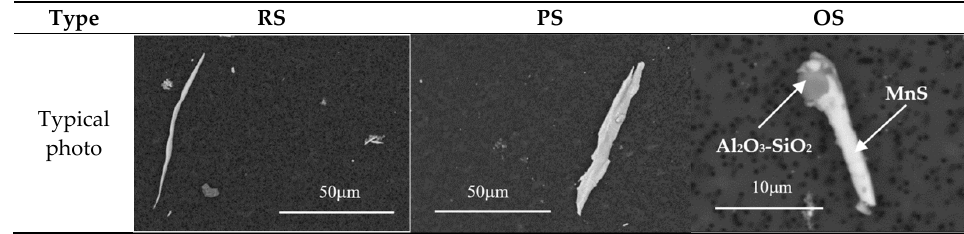
Figure 3. Typical sulfide inclusions observed in steel